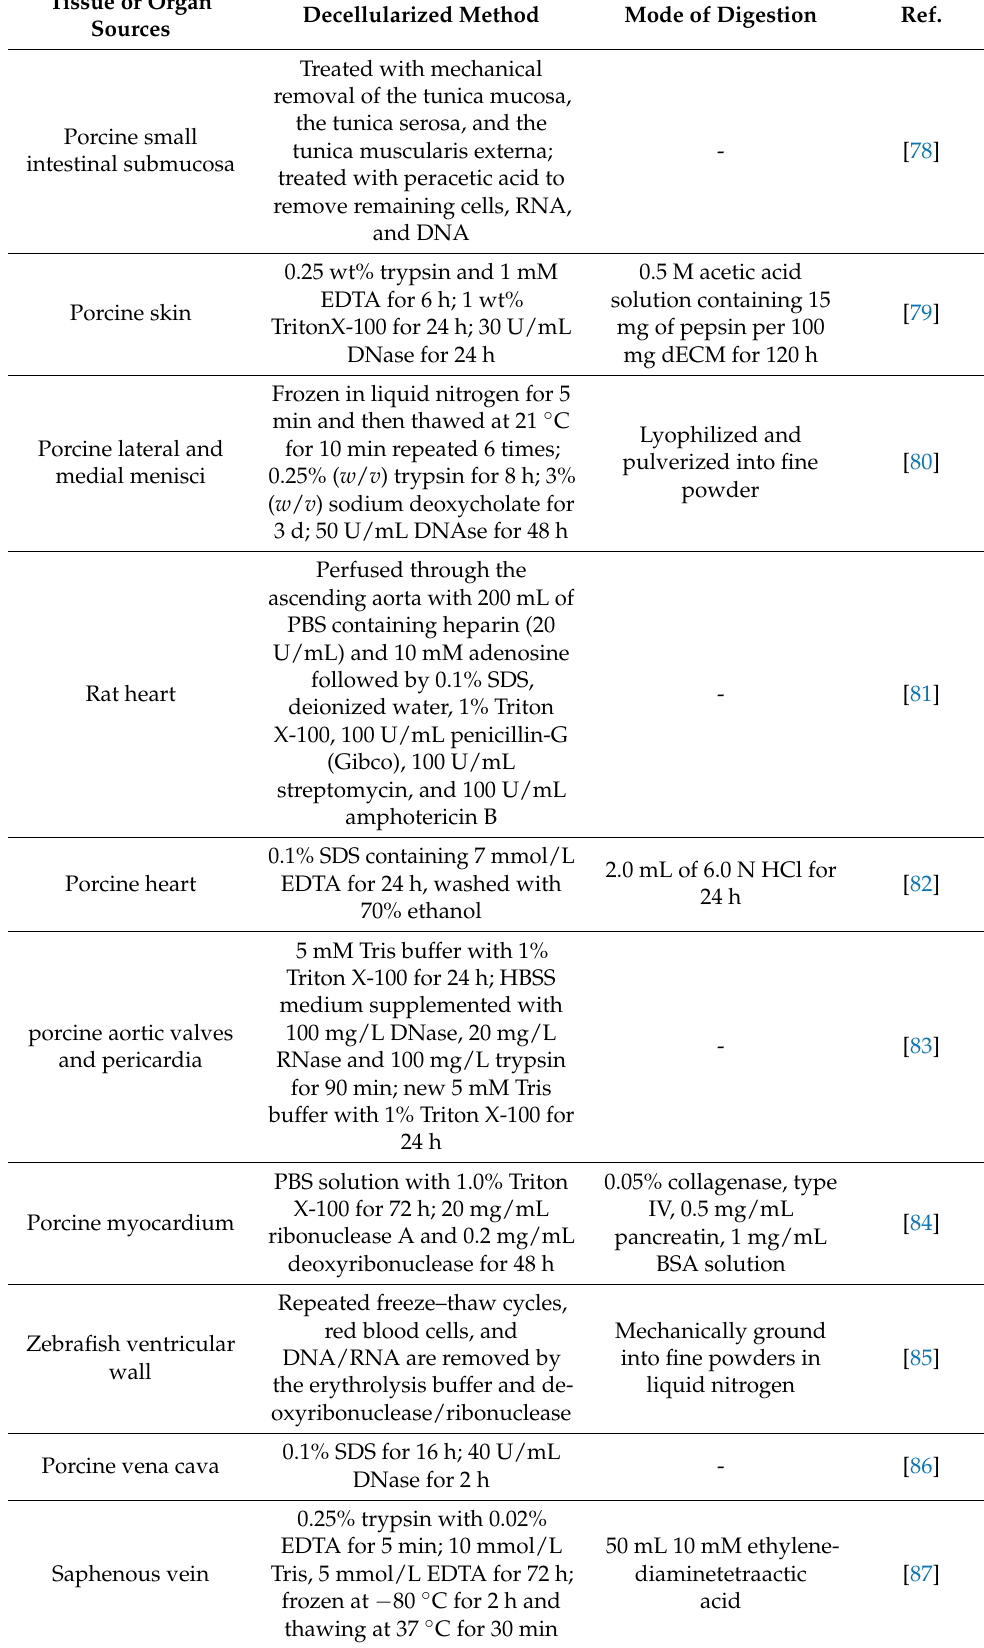
Table 1. Cont. Tissue or Organ